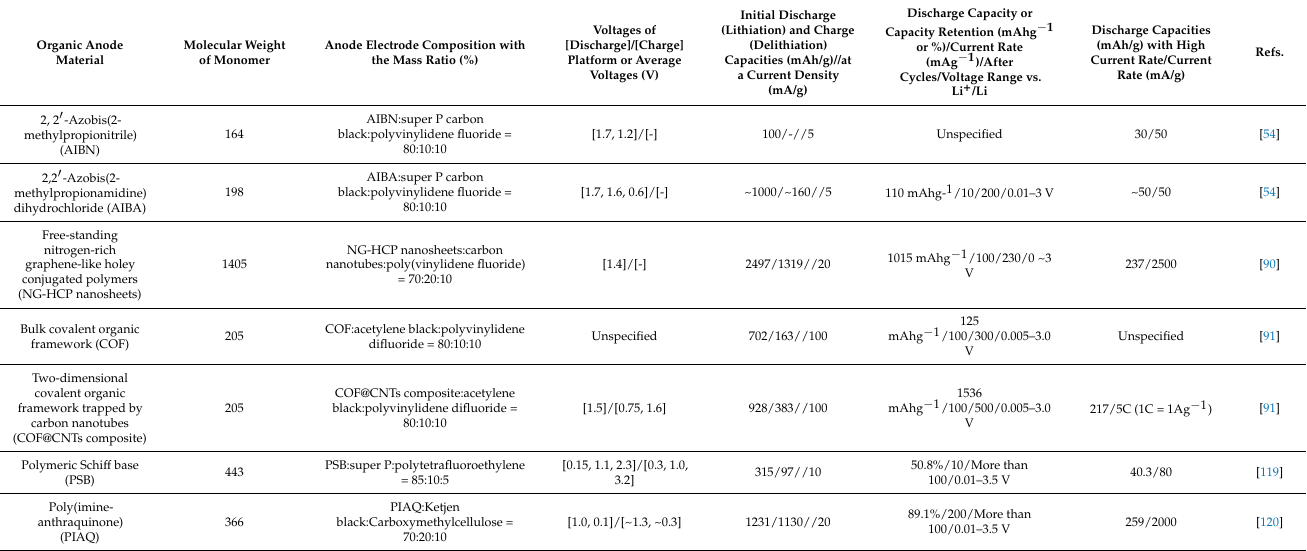
Table 4. Summary of the electrochemical properties of organic anode materials with nitrogen- containing groups employed as an anode for